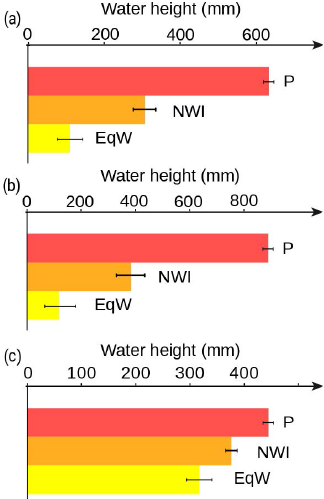
Figure 6. Precipitation, net water inflow and EqW during recharge period for the (a) SEOU site, (b) BESS site and (c) BEAU site.